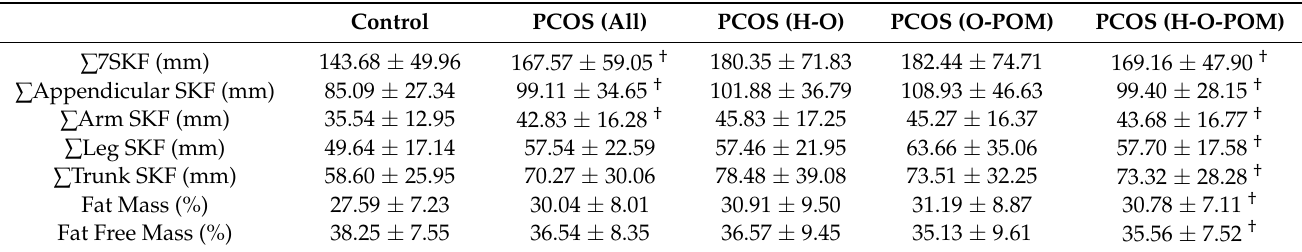
Table 2. Descriptive values of the skinfolds’ measurements, fat mass and fat-free mass (bone +lean mass) in control and PCOS subjects.